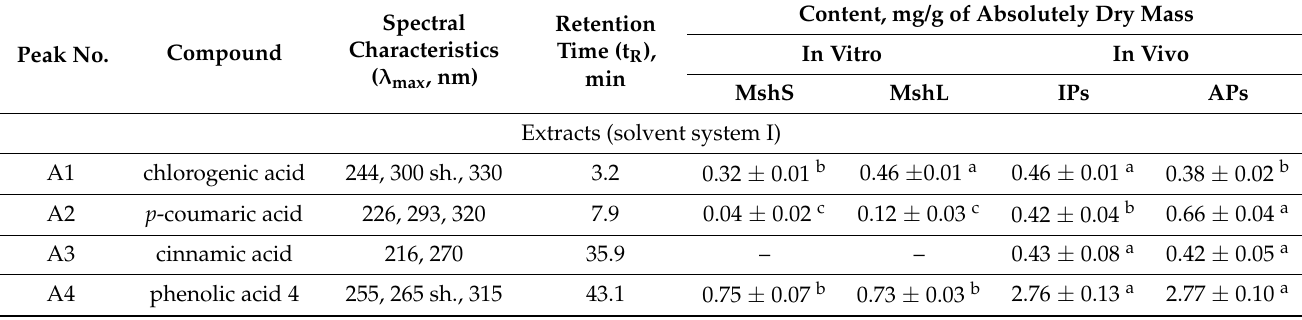
Table 2. Characteristics and levels of the phenol carboxylic acids detected by HPLC in S. betulifolia ssp. aemiliana